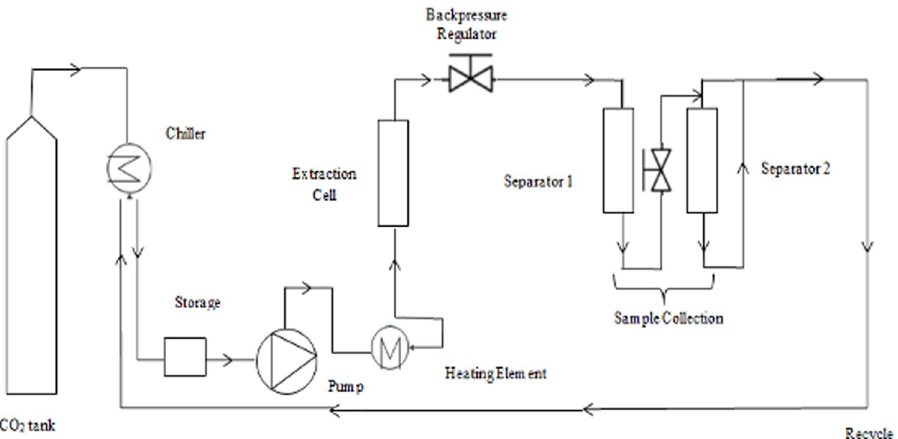
Fig 1. Schematic representation of the supercritical carbon dioxide extraction